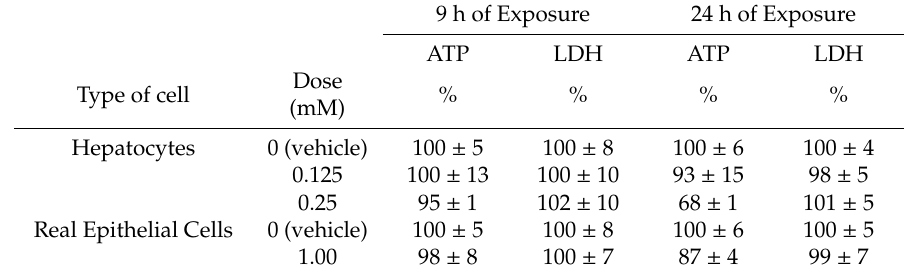
Table 6. Relative LDH and ATP levels to assess viability of human hepatocytes and renal proximal tubular epithelial cells exposed to thioacetamide-S-oxide for 9 or 24 h compared to vehicle-exposed cells at the same time points. Data are presented as mean ± standard error of the mean (SEM) ( n = 5 per group).